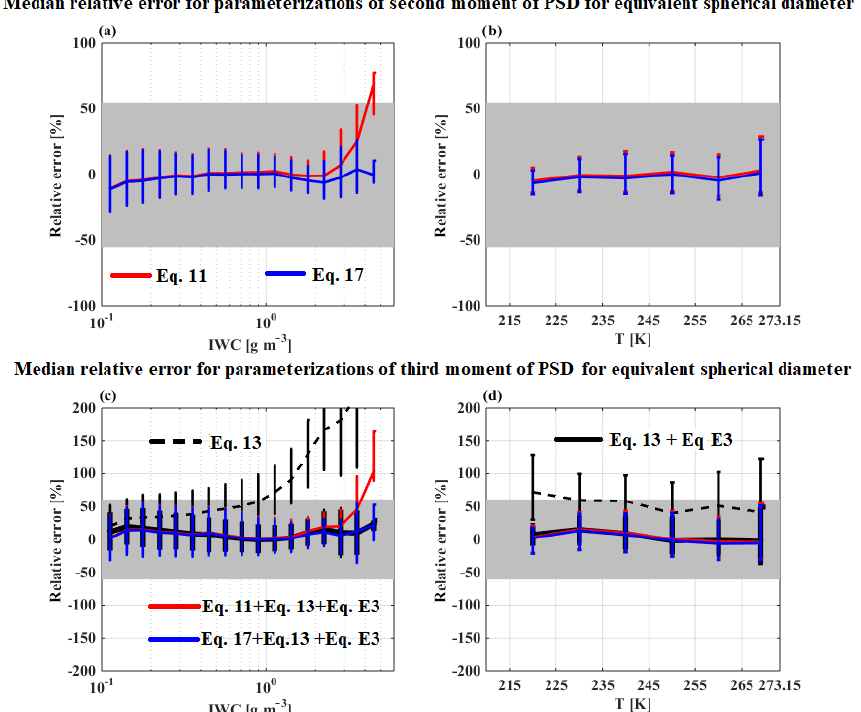
Figure E7. Relative error of parameterized M 2 , Dsp and M 3 , Dsp for the merged dataset as a function of IWC in (a) and (c) and as a function of T in (b) and (d) . The solid lines give the median relative error and the whiskers denote the 25th and 75th percentiles of relative error. The grey bands shows measurement uncertainties for M 2 , Dsp (55%; a and b ) and M 3 , Dsp (61%; c and d ), respectively, for PSD as a function of equivalent spherical diameter.